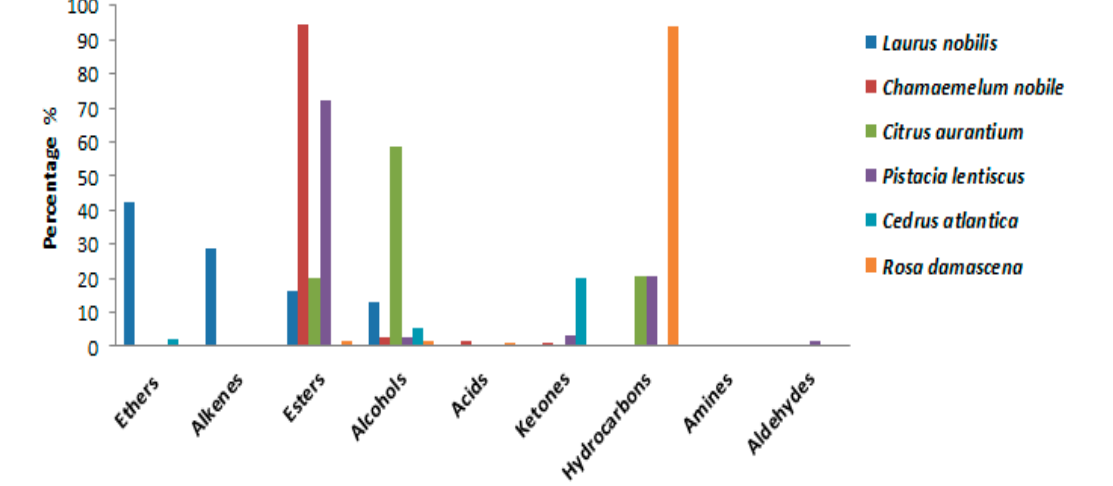
Figure 2. Chemical families identified in the EO S of plants species (%).